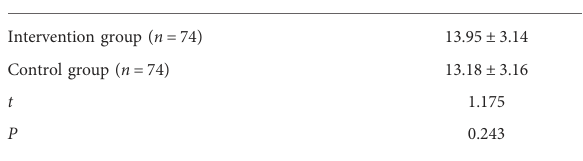
TABLE 3 Comparison of nursing satisfaction between the two groups ( (cid:1) x + S ,